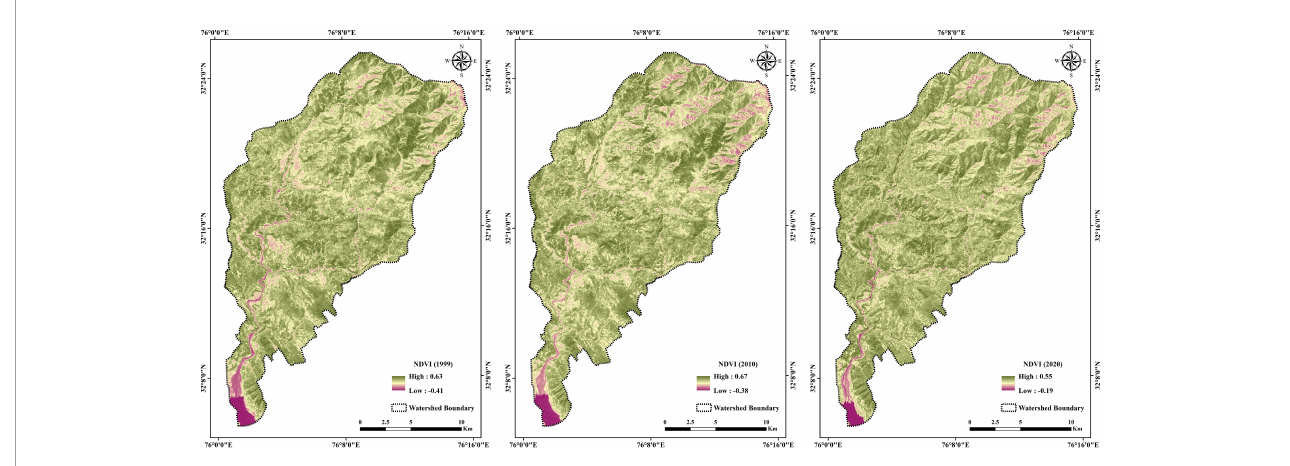
FIGURE6 Maps of the Dehar watershed showing NDVI for the years 1999, 2010, and 2020.